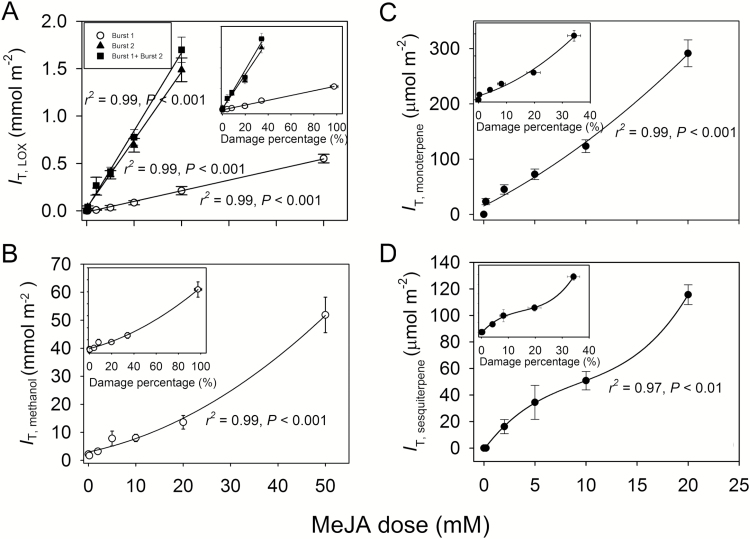
Integrated emissions (IT, Equation 1) of lipoxygenase pathway volatiles (IT,LOX, A), methanol (IT,methanol, B), monoterpenes (IT,monoterpene, C), and sesquiterpenes (IT,sesquiterpene, D) in relation to the applied MeJA concentration and corresponding relationships with the degree of damage (insets) in leaves of C. sativus (see Fig. 2 for the sample kinetics of the emissions). In (A), the data for the first and the second emission burst of LOX and the sum of the two are separately shown and fitted by linear regressions (for the main panel, y=0.0112x–0.0124 for the first and y=0.0716x+0.0322 for the second LOX burst; for the inset, y=0.00576x–0.0080 for the first and y=0.0409x+0.023 for the second LOX burst). For IT,methanol in (B) and for IT,monoterpene in (C), the data were fitted by second-order polynomial regressions [for the main panels, y=0.0093x2+0.99x+1.62 for (B) and y=0.22x2+9.43x+15.2 for (C); and for the insets, y=0.0026x2+0.25x+2.66 for (B) and y=0.12x2+3.85x+17.8 for (C)]. For IT,sesquiterpene in (D), the data were fitted by sigmoidal regressions {y=127/[1+e(11.3−x)/4.20] for the main panel and y=161/[1+e(25.8−x)/9.16] for the inset}. MeJA treatment is as in Fig. 1. For all relationships in (A) and (B) and for the main panel of (C), r2=0.99, P<0.001. For the inset of (C), r2=0.98, P<0.01 and for the main panel and the inset of (D), r2=0.96, P<0.01. Three replicate treatments at each MeJA application concentration were carried out.